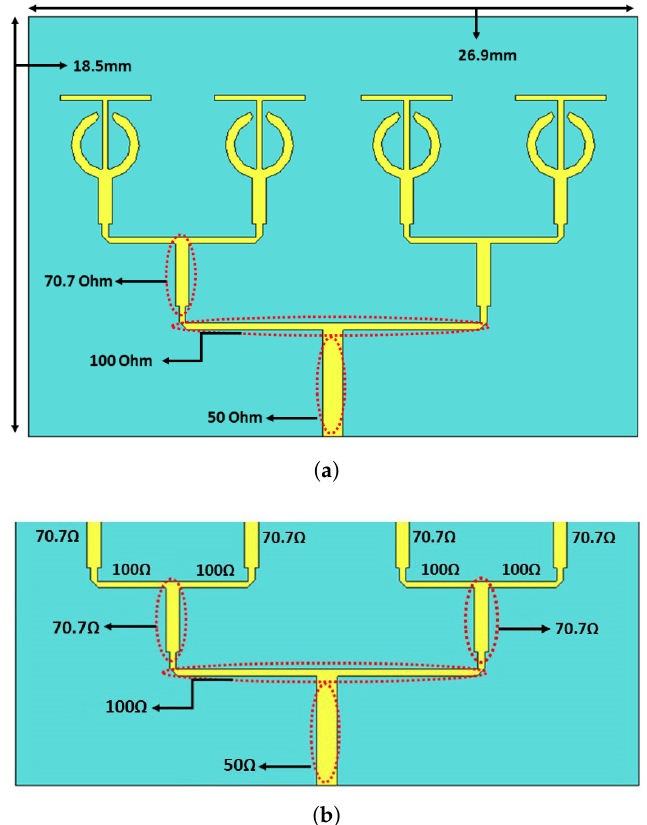
Figure 5. Proposed antenna array transformation: ( a ) array structure; and ( b ) equivalent model for impedance